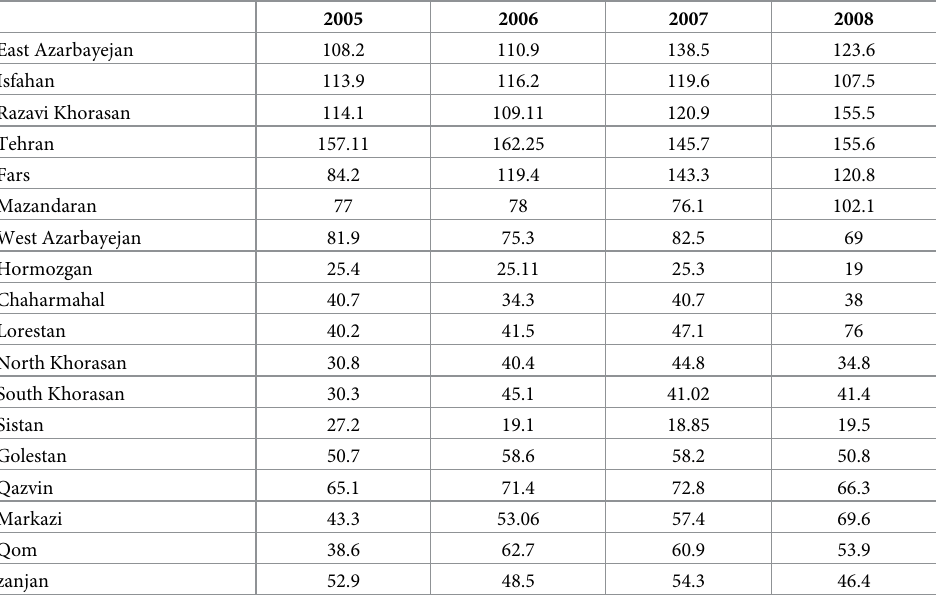
Table 1. Expected coverage of cancer cases in provinces of Iran (2005–2008).